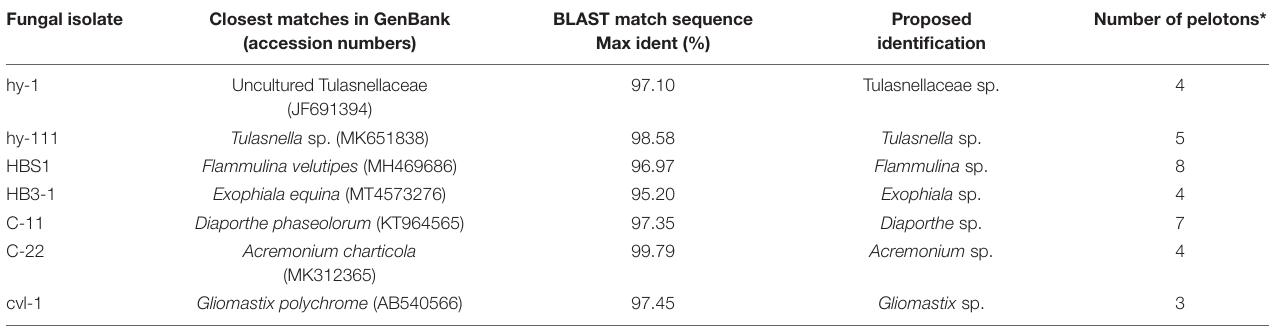
TABLE 1 | Seven fungal strains isolated from roots of Coelogyne viscosa. Fungal